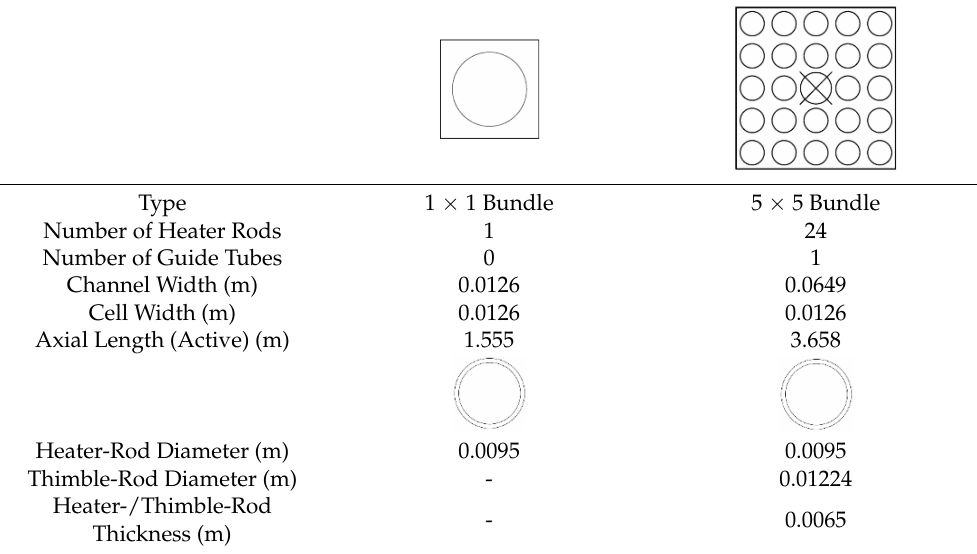
Table 1. 1 × 1 and 5 × 5 geometry from the PSBT (PWR subchannel and bundle tests) benchmark.